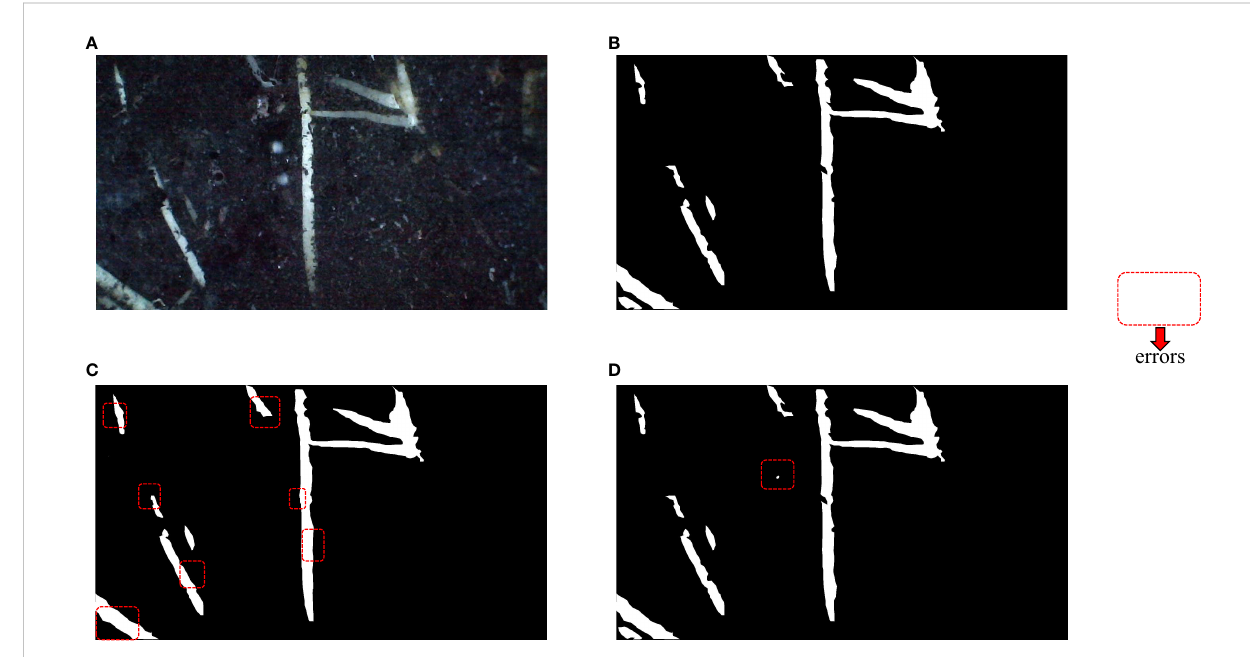
FIGURE 9 Visualization of segmentation effects. The red dashed boxes represent signi fi cant differences from the real mask. (A) In situ root system, (B) Labeled real mask map, (C) Unet segmentation effect display, (D) PRUnet segmentation effect display.